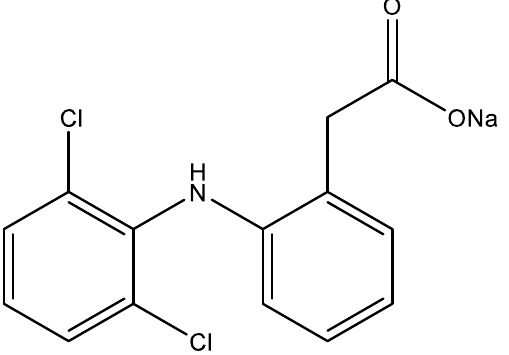
Figure 2. Structural formula of diclofenac sodium.